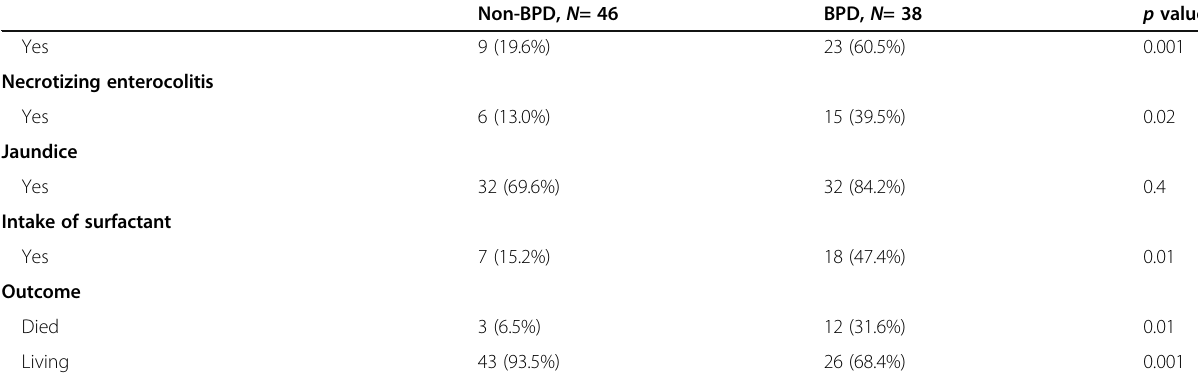
Table 1 Demographic and clinical data (Continued)